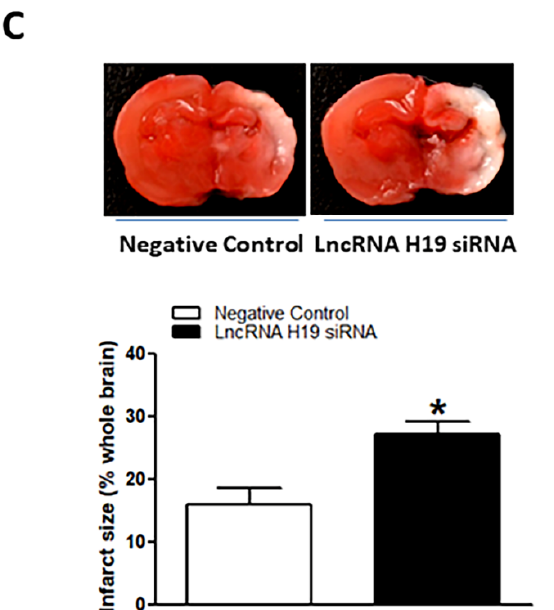
Figure 6. Inhibition of lncRNA H19 upregulated miR-181a expression and enhanced H/I-induced brain injury in neonatal pups. lncRNA H19 siRNA and negative control were administered intracerebroventricularly (i.c.v.) on postnatal day 7 (P7) pups, and H/I procedure was conducted on P9 pups. Levels of lncRNA H19 ( A ) and miR-181a ( B ) were evaluated by qRT-PCR analysis in neonatal rat brain on P9 pups. LncRNA H19 siRNA administration not only reduced expression levels of lncRNA H19 but also significantly enhanced expression of miR-181a in neonatal rat brains ( A , B ). Of importance, knockdown of lncRNA H19 also increased H/I-induced brain infarct size as compared to the negative control group ( C ). Data are means ± SEM. * p < 0.05, control vs. lncRNA H19 siRNA. n = 5 animals/group. Brain infarct size ( C ) was determined by TTC staining 48 h after H/I procedure. Data are means ± SEM. * p < 0.05, control vs. lncRNA H19 siRNA. n = 9–11 animals/group.